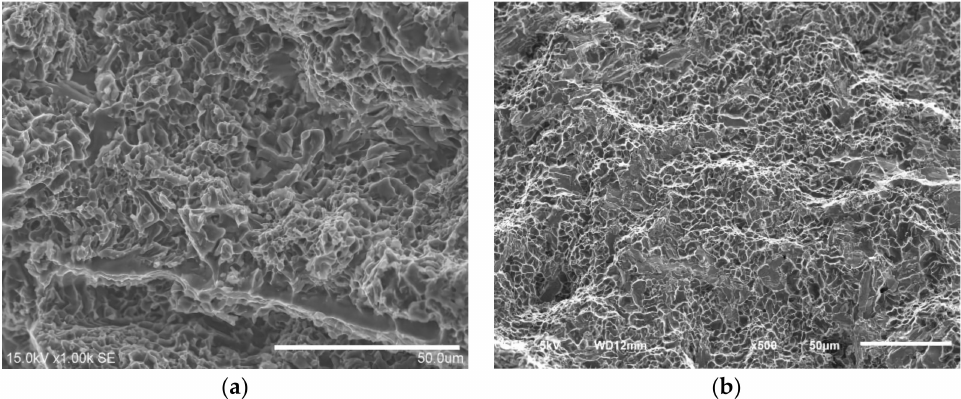
Figure 3. Tensile fracture SEM scanning image of an AlSi10MgMn alloy in the ( a ) cast state; ( b ) T6 heat-treated